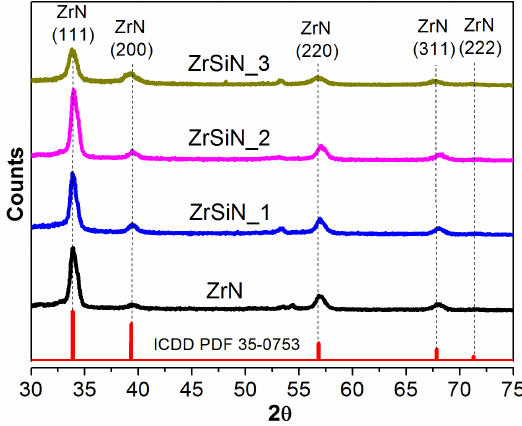
Figure 2. Grazing angle (1°) XRD analysis – (111) peak intensity reduction and broadening for ZrSiN_3 sample. It can be verified the (111) preferred orientation for ZrN and ZrSiN thin films. The peaks intensities obtained from ICDD PDF 35-0753 are also presented.